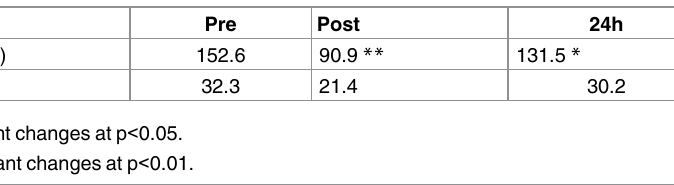
gave weaker signals. Next, we determined whether these antibodies detected the titin fragment in human urine samples. As shown in Fig 3B, clones 7D3 produced signals in the urine sam- ples obtained after eccentric exercise but not in the preexercise samples. The monoclonal anti- body, clone 2B3, produced strong signals in the postexercise sample and moderate signals in the preexercise samples.